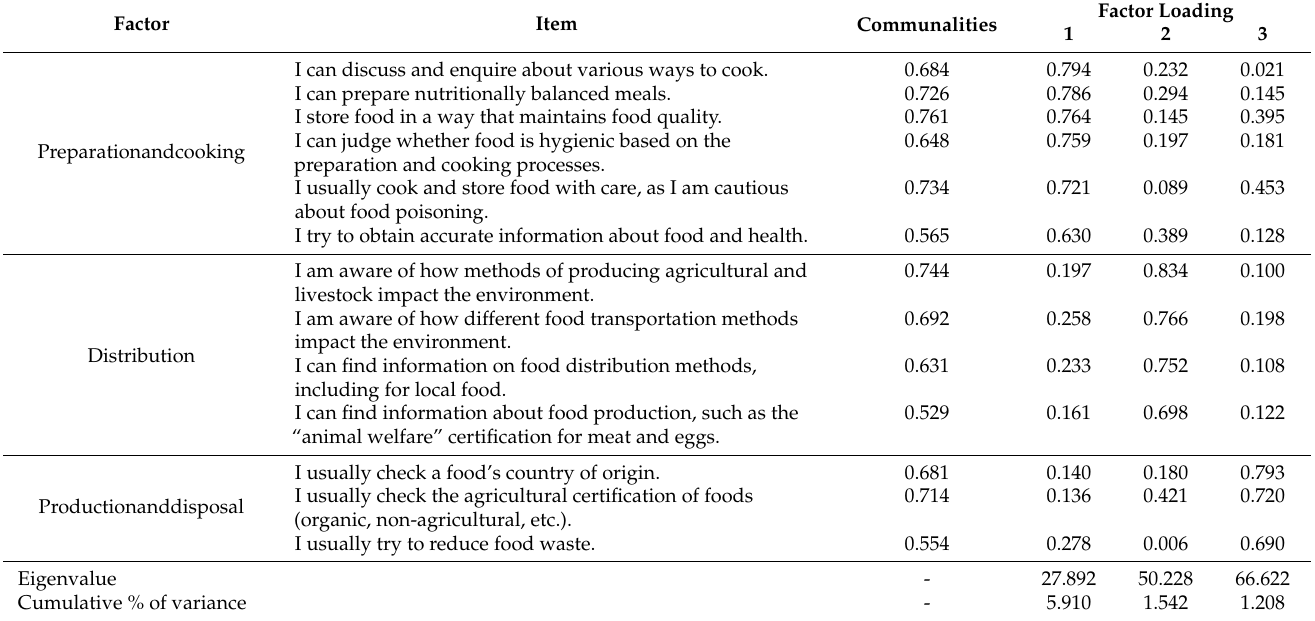
Table 3. Results of the EFA ¶ on the final questionnaire ( n =